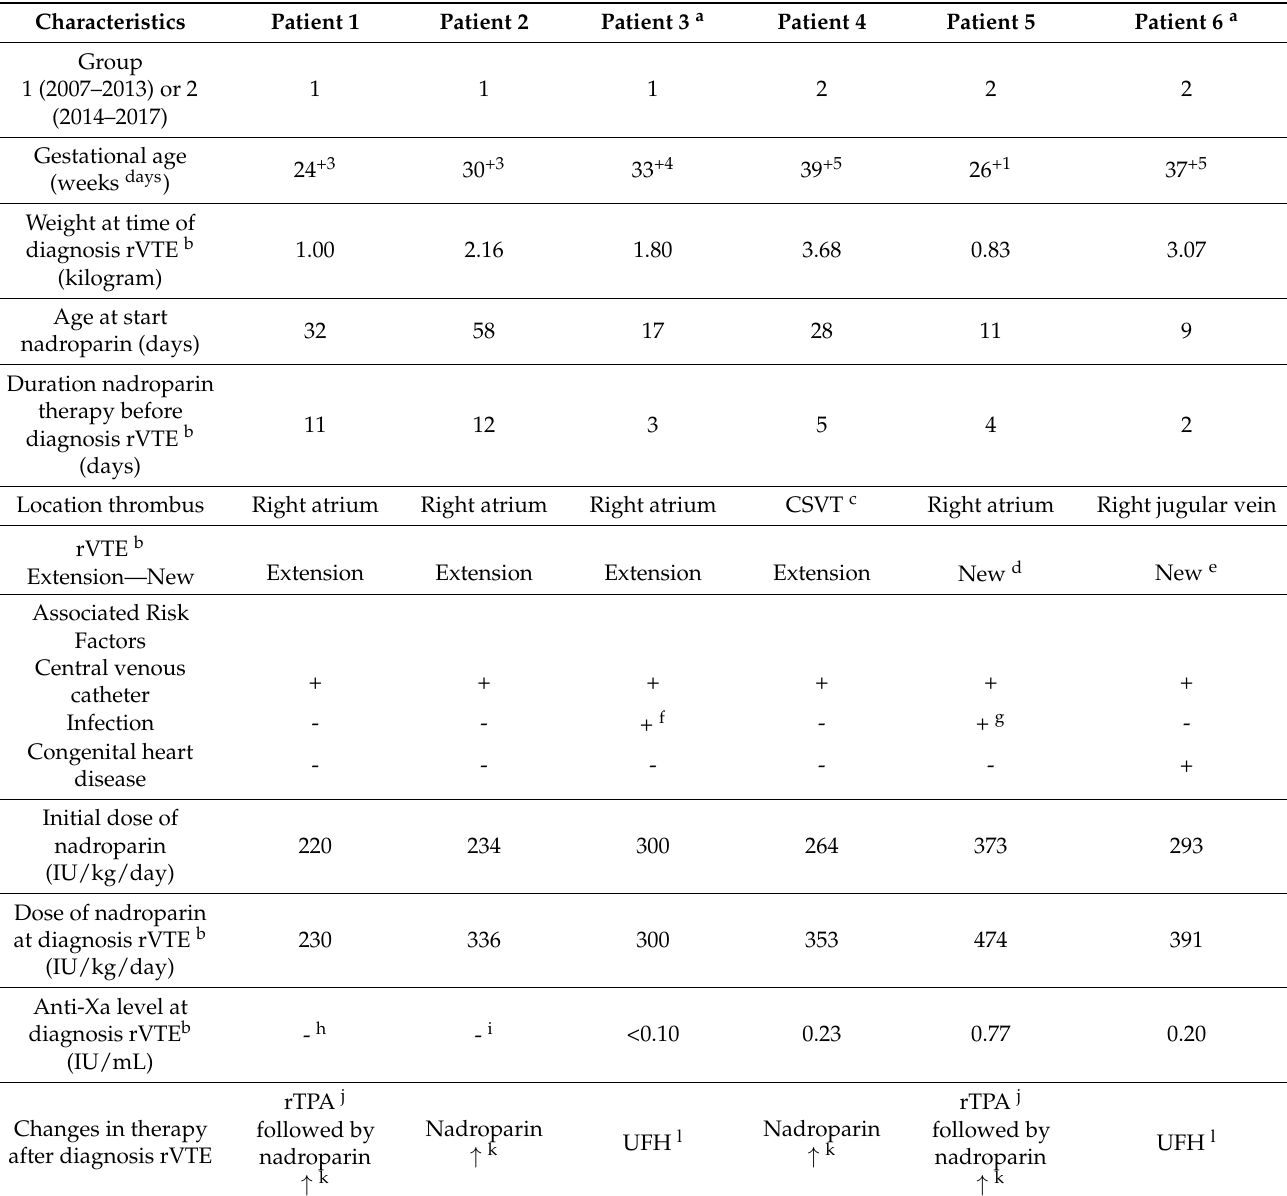
Table 3. Characteristics of 6 neonates diagnosed with recurrent thrombosis during nadroparin